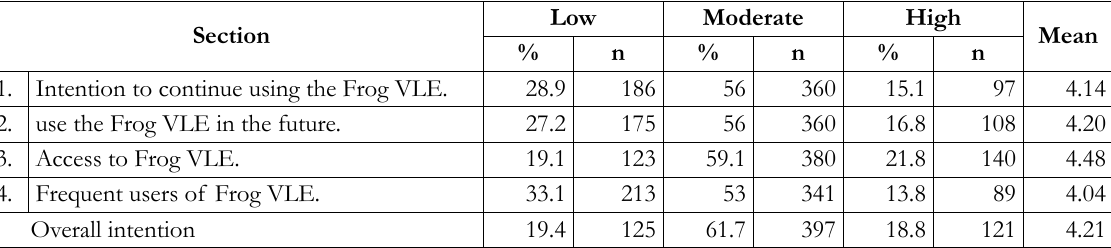
Table 4. The Level of Intention to Continue Using VLE in the Future among Malaysian